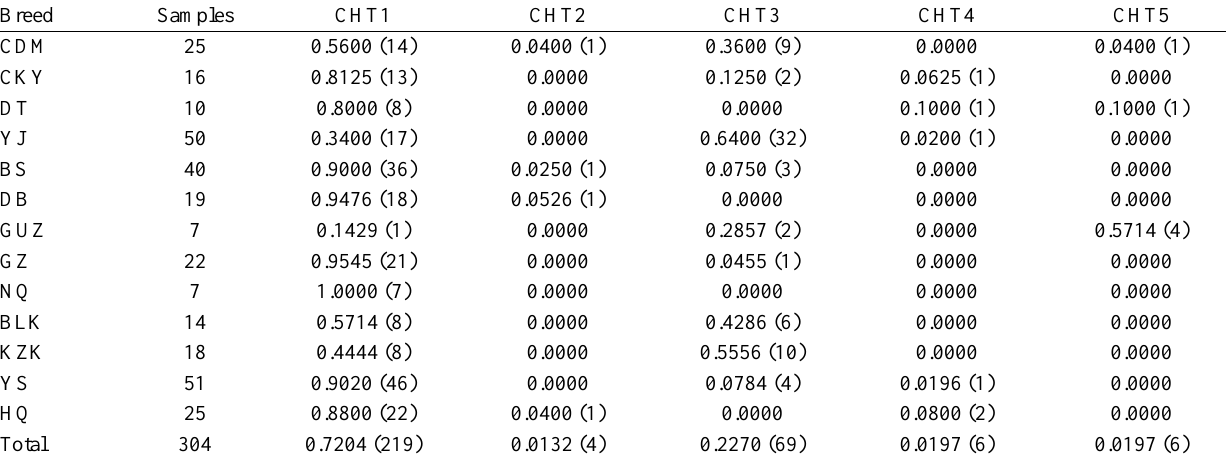
Table 5. The frequencies of five Y chromosome haplotypes in 13 Chinese horse breeds Breed